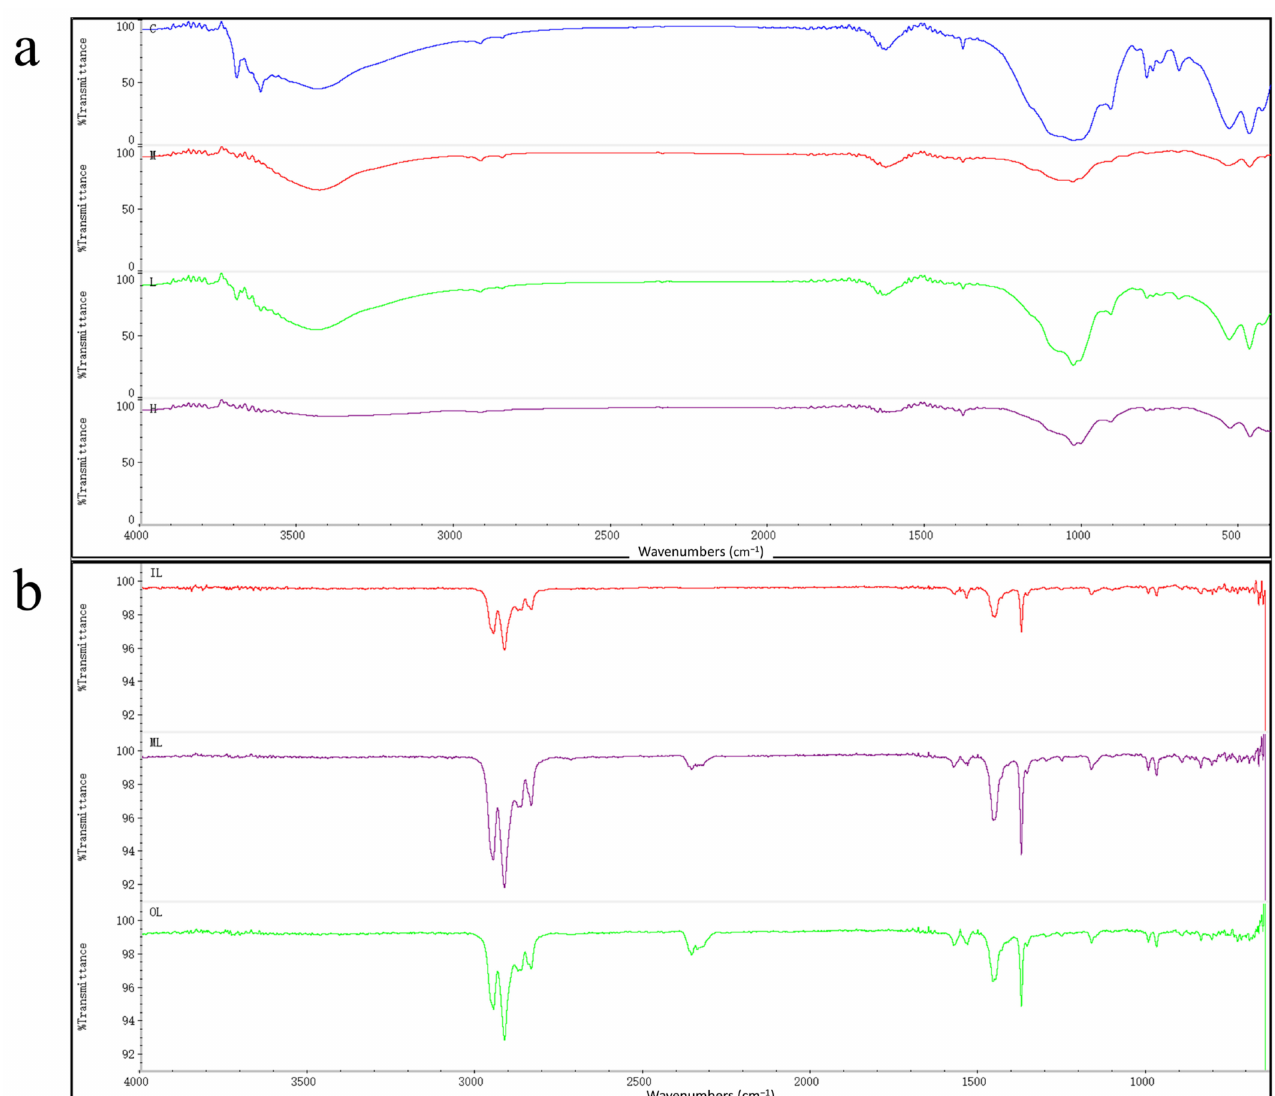
Figure 3. ( a ) C, L, M, and H are the FT-IR spectra of each group of collected samples, respectively; ( b ) OL, ML, and IL are the infrared spectra of the outer, middle, and inner layers of disposable medical mask,